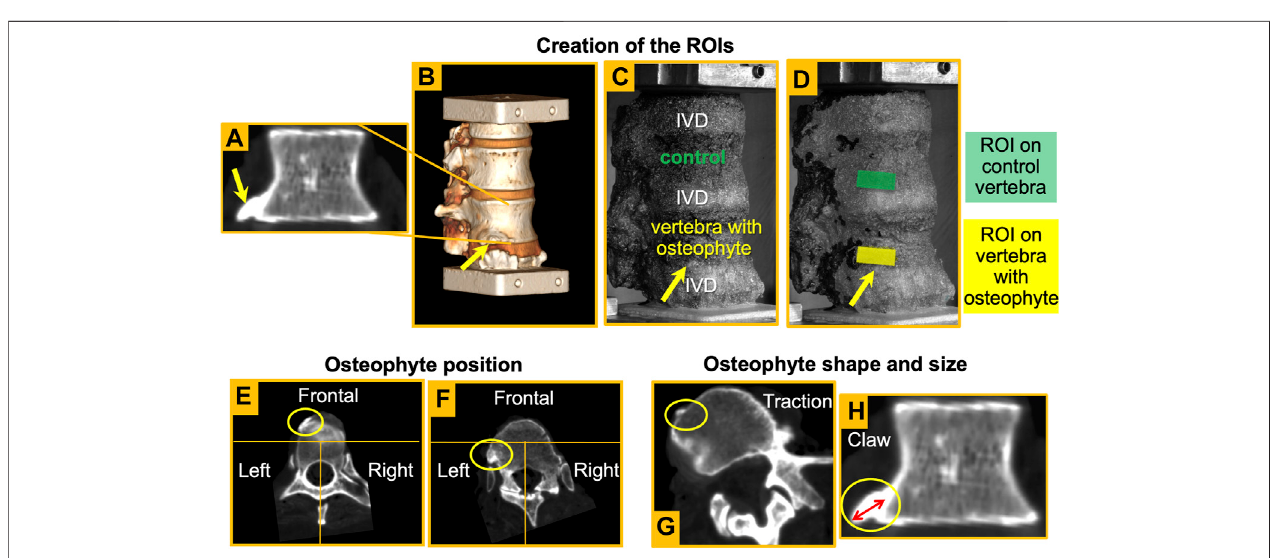
FIGURE 1| – Coronal slice of an L1 vertebra with an osteophyte (A). Shape and sizeof the osteophyte were assessed from these views. Reconstruction of the 3D rendering (B) and detection oftheosteophytein theimage taken bytheDIC system(yellow arrow) (C). Creation ofthe ROIsboth inthe vertebra with theosteophyte and in the control vertebra (D) . De fi nition of the osteophyte position: examples of an osteophyte in the frontal area (E) and one on the left (F) . De fi nition of osteophyte shape: examples of a traction spur (G) and a claw osteophyte (H) . De fi nition of osteophyte size (H) according to the method described by Wilke et al.